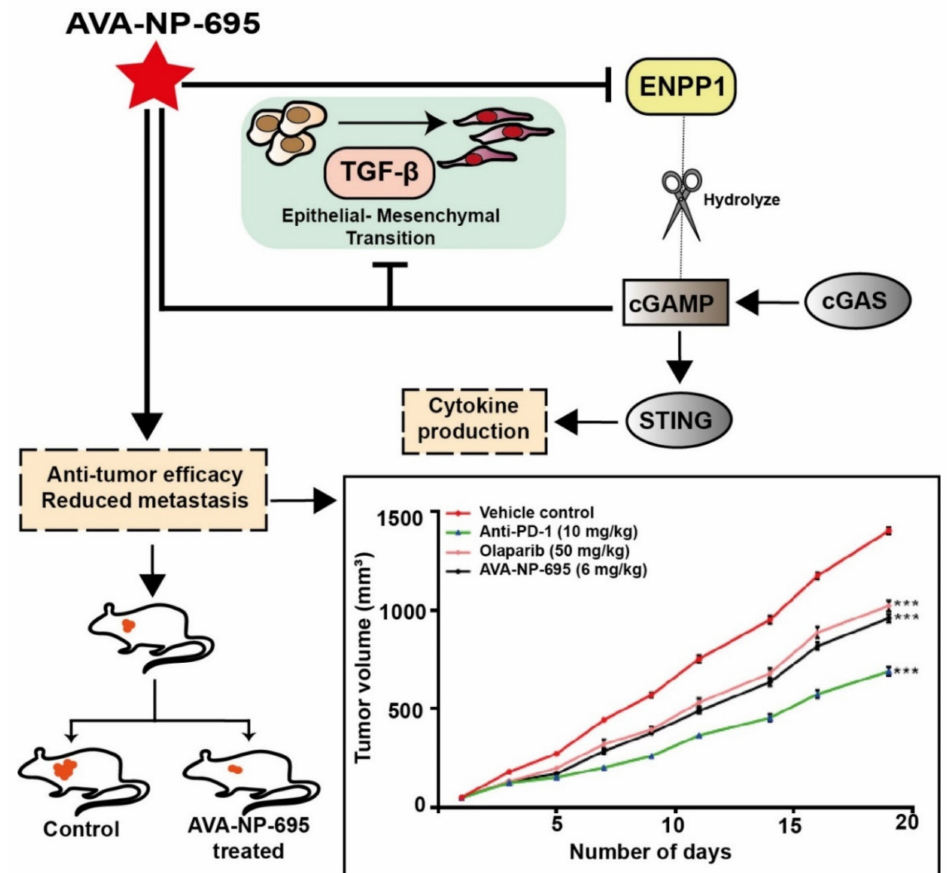
Figure 7. Schematic representation of the study. Apart from immune cell activation, ENPP1 inhibition increases cGAMP levels, thereby negatively regulating the epithelial–mesenchymal transition crucial for metastasis. Hence, ENPP1 inhibition reflects negatively on tumor growth not only by activating immune cells but also by reducing metastasis. *** p < 0.001.